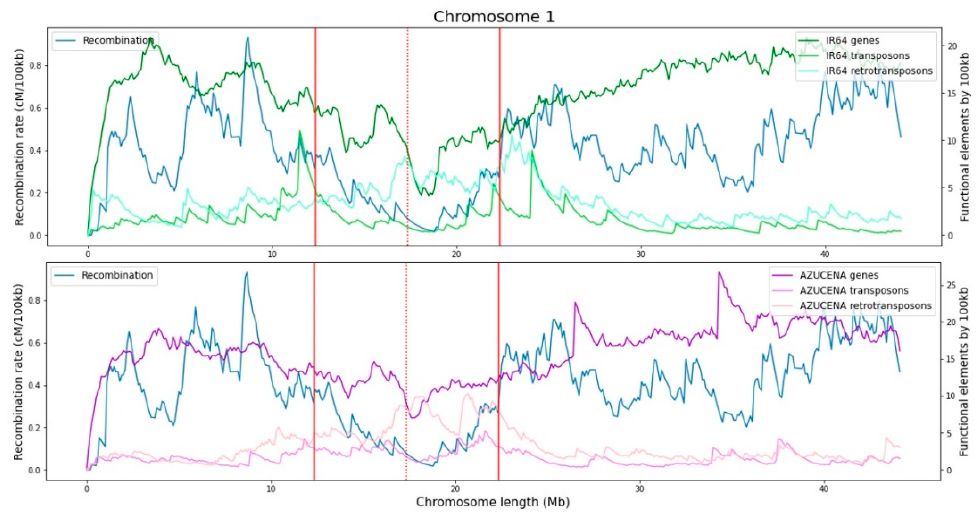
Figure 4. Genes, transposons, and retrotransposons compared to cross over recombination through chromosome 1 for rice varieties IR64 and Azucena. The centromere is represented by a red dotted line and the influence of the centromere region in recombination by solid red lines.